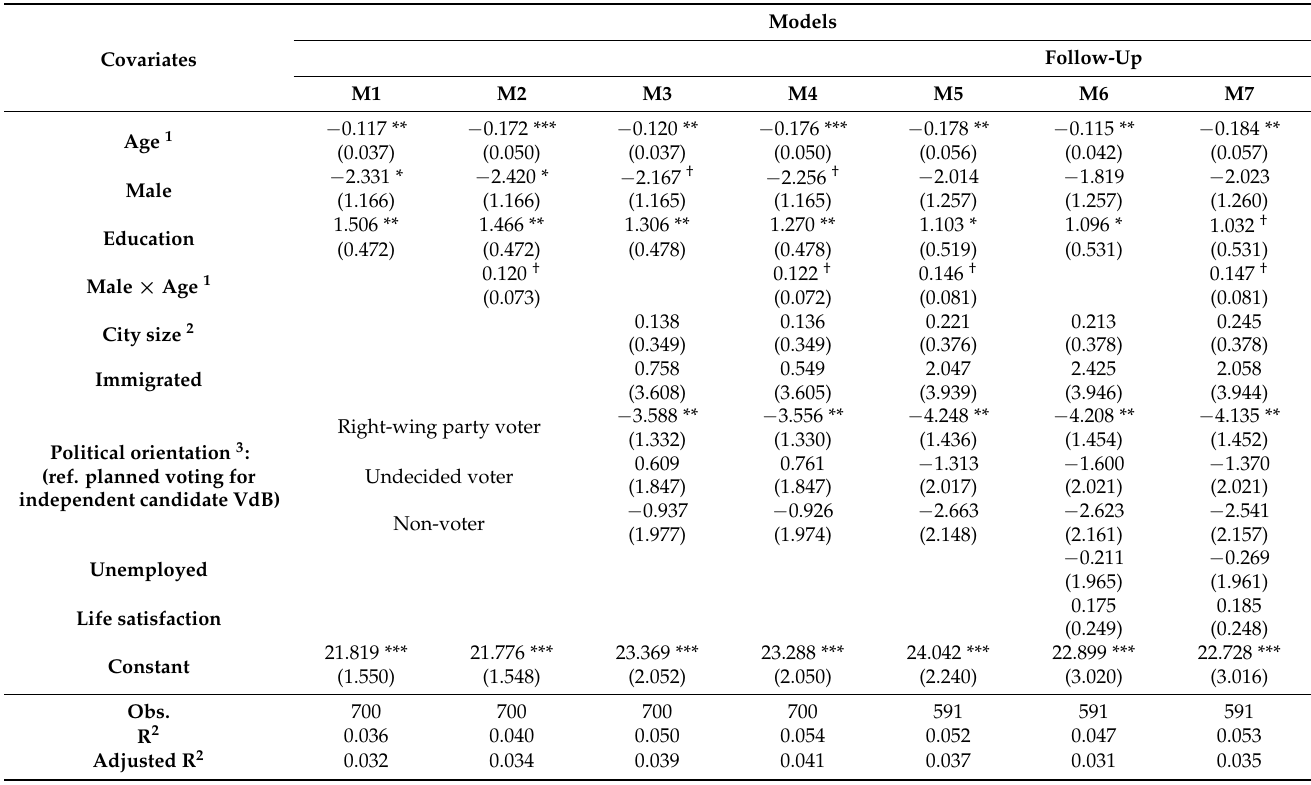
Table 3. Results from multivariate regression with individuals Social Value Orientation (SVO) as the dependent variable. Follow-up models included only observations from respondents participating in the primary and follow-up data collection.